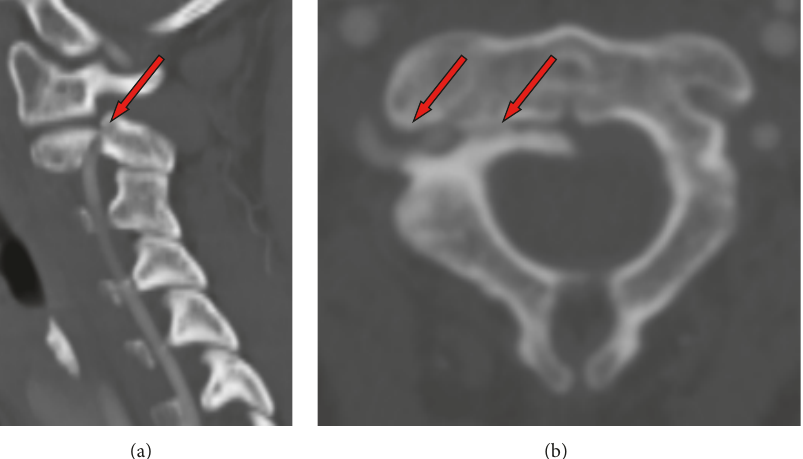
Figure 3: CT with contrast of fracture featuring a partial ossification and artery dislocation after three months: (a) sagittal view and (b) axial